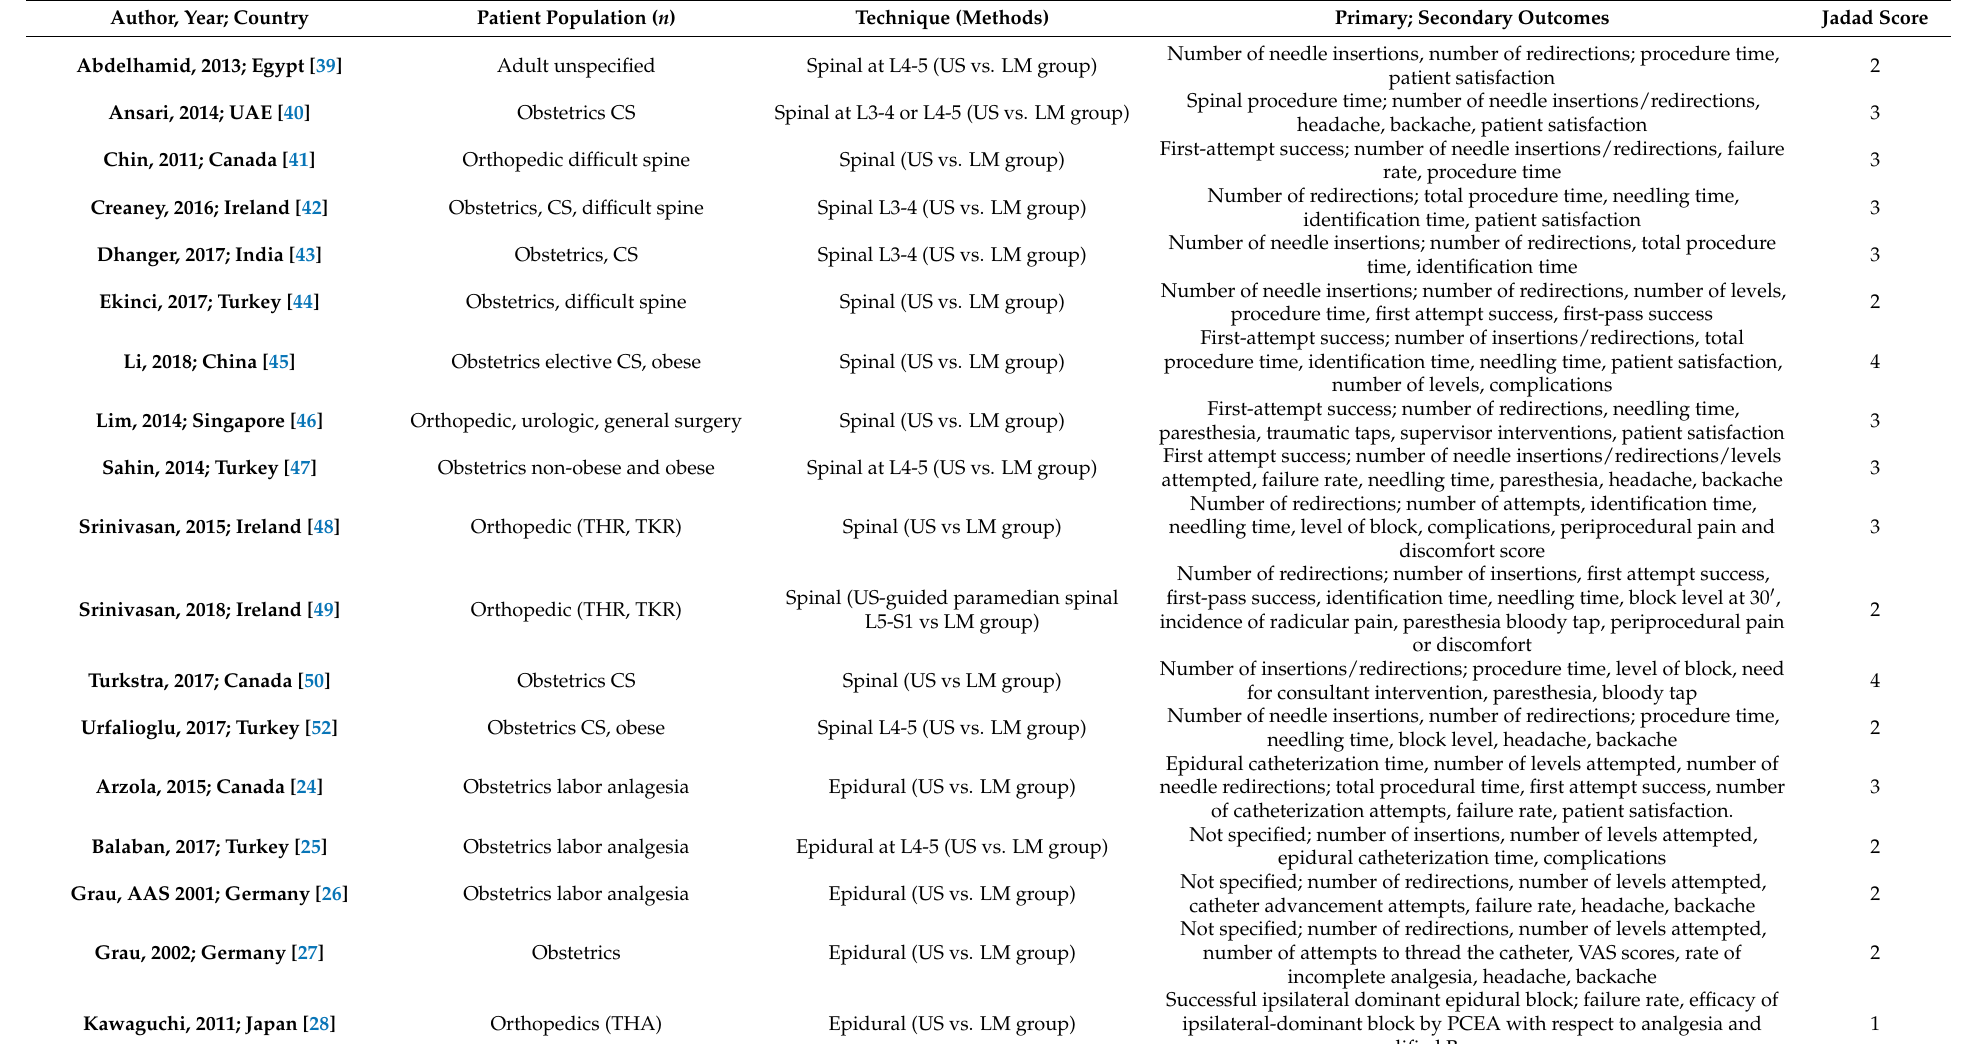
Table 1. Characteristics of eligible